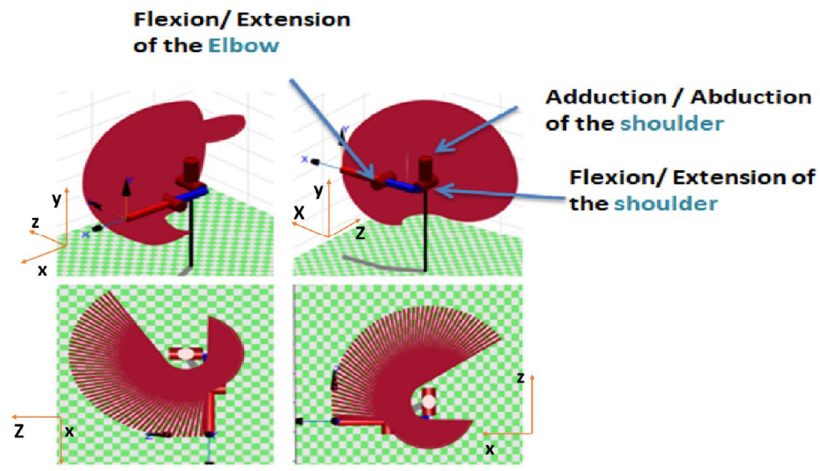
Figure 21. Different screenshots of the dexterous workspace for the arm exoskeleton SAMA.